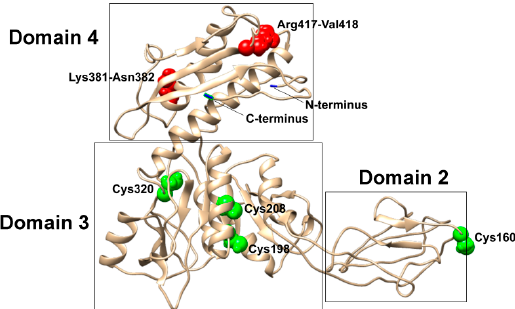
Figure 1. A model of gp053 generated by I-TASSER. The locations of the N and C termini are shown in blue; Cys160, Cys196, Cys208 and Cys320 are shown in green; Lys381-Asn382 and Arg417-Val418 are shown in red. The domain numbering was done according to Kurochkina et al. [38]. The model was visualised using UCSF Chimera.